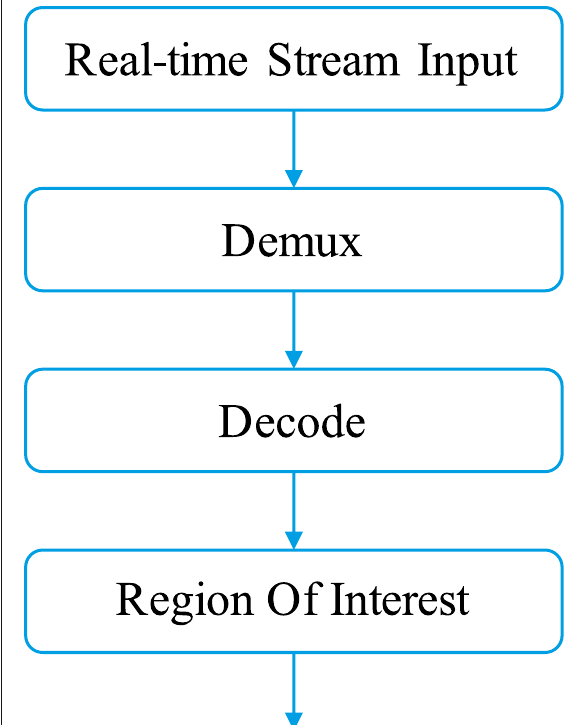
approaches for applying AI to IoT. They further proposed an architecture that preserves the advantages of both edge processing and server-based/cloud-centric computing for AI algorithms. Debauche et al. [29] proposed a new